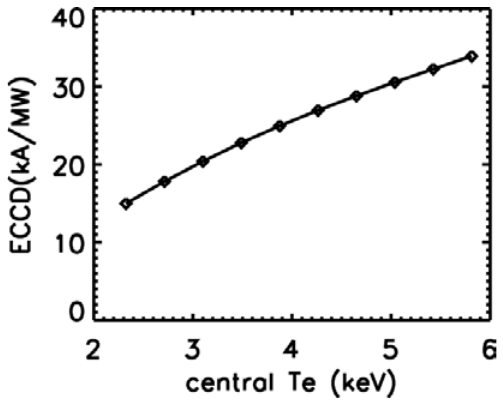
Figure 10: ECCD driven from top launch increases with the electron